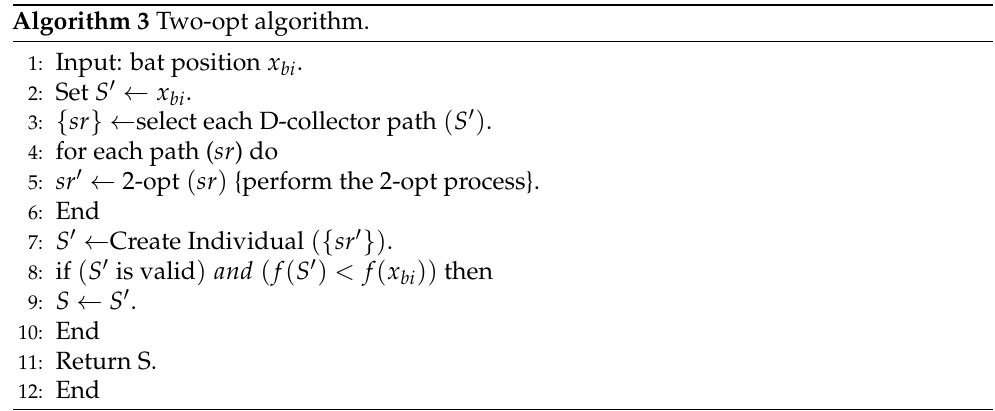
Algorithm 3 Two-opt